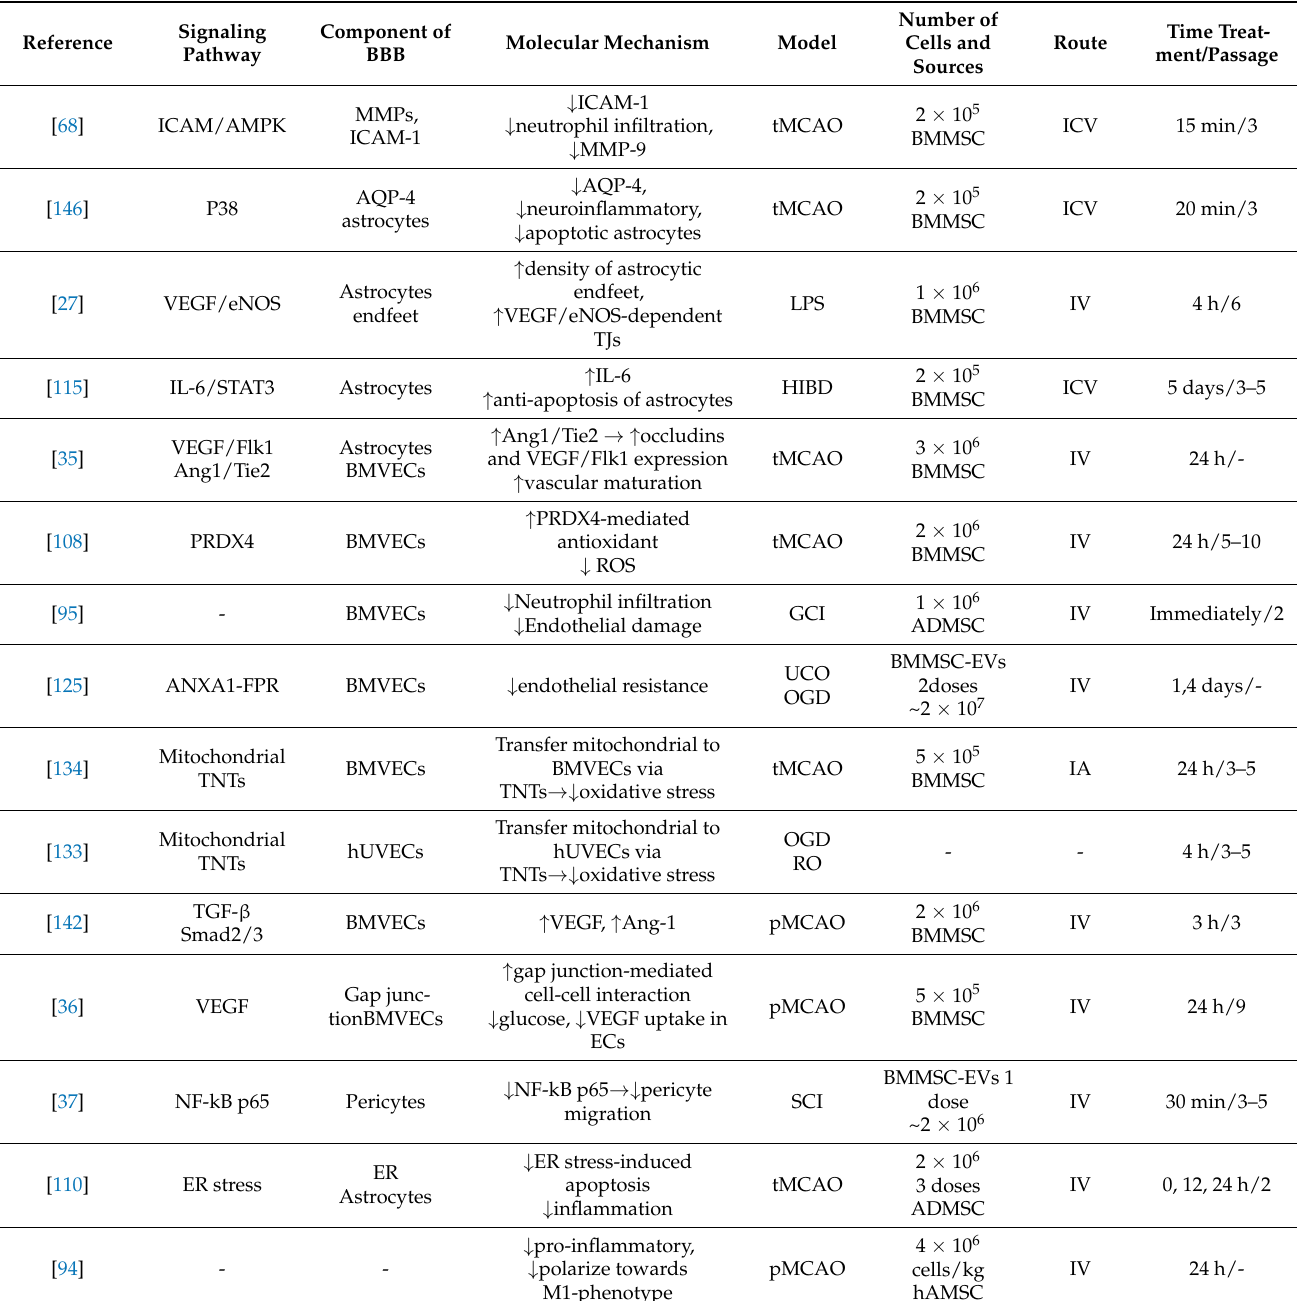
Table 1. Investigation of the molecular mechanism of MSC therapy in blood–brain barrier preservation after ischemic brain